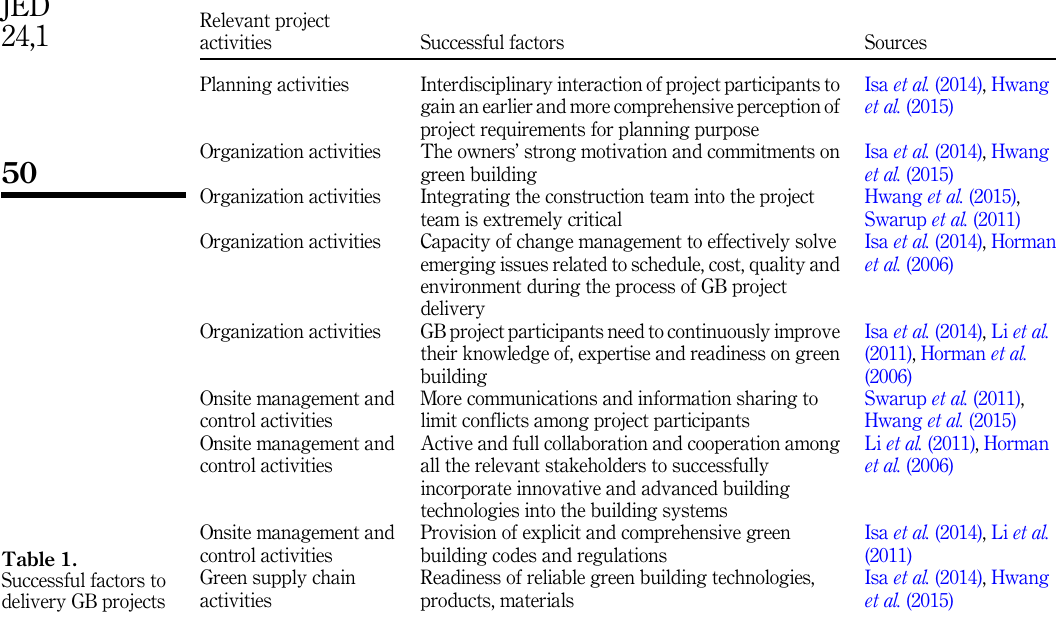
Table 1. Successful factors